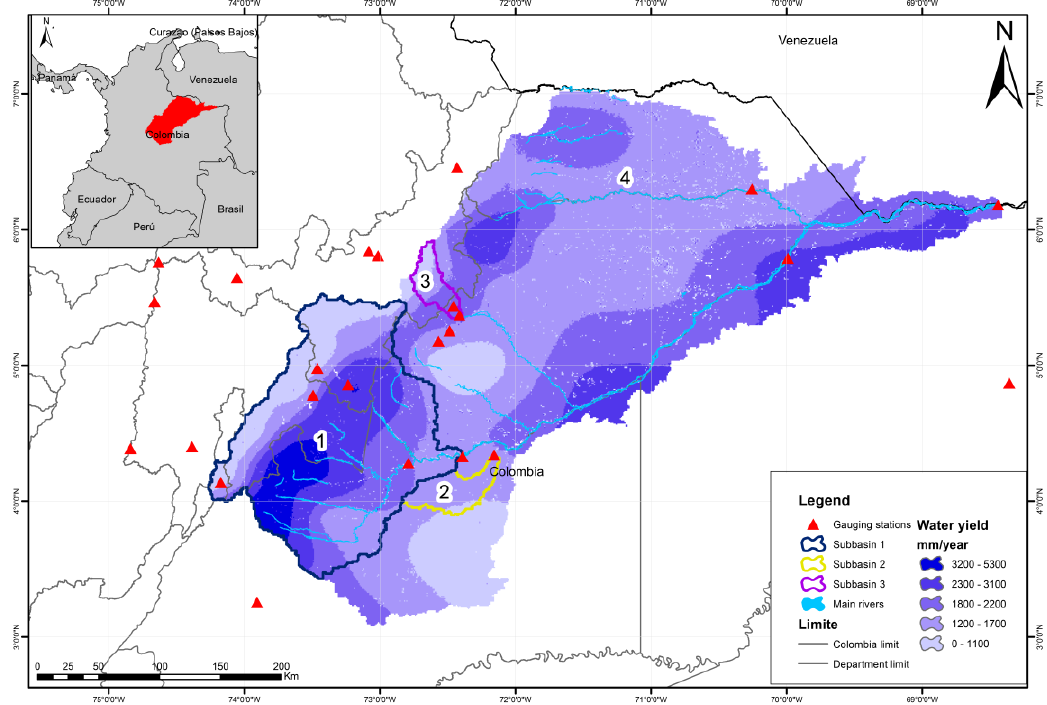
Figure 6. Annual water yield formation in the subbasins of the Meta River basin for 2018. (1)